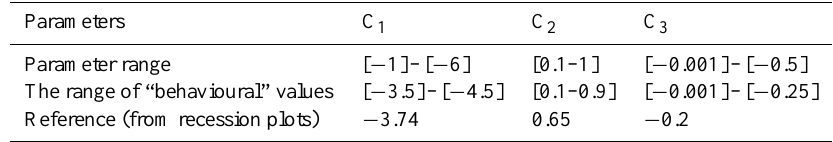
Table 10. Comparison of the chosen parameter range and parameters obtained from low-vegetation periods for the Ardèche at Meyras (#1) catchment.